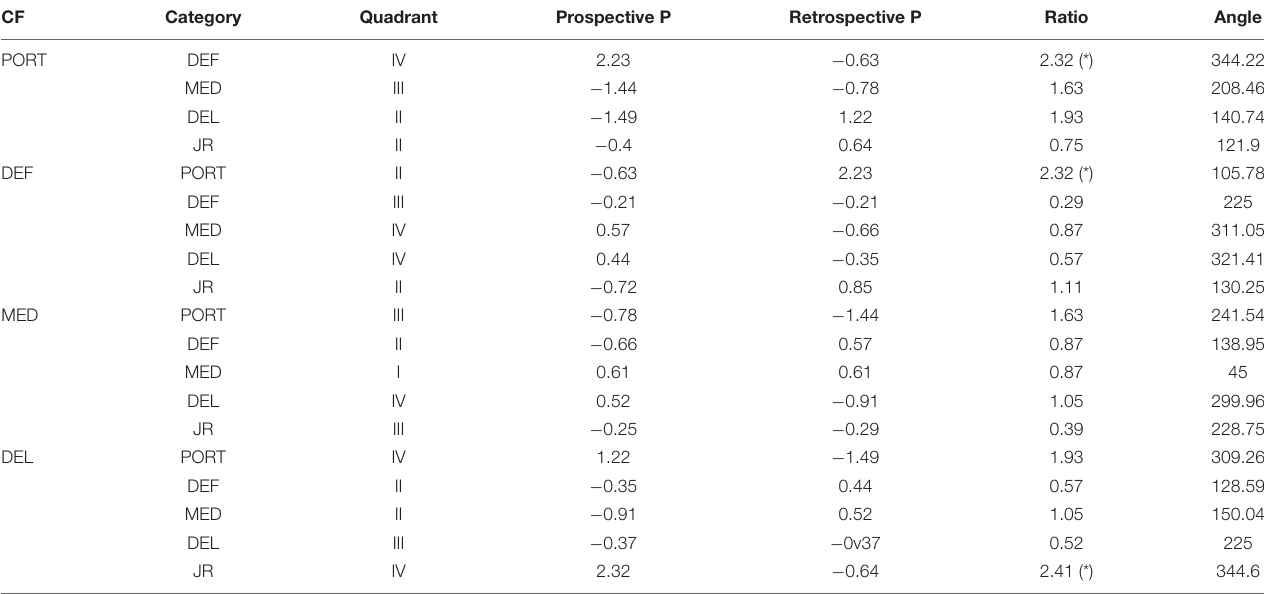
TABLE 12 | Results of the analysis of polar coordinates for the different focal categories in relation to the rest of the lines that make up the game structure of the 2016–2017 season. CF Category Quadrant Prospective